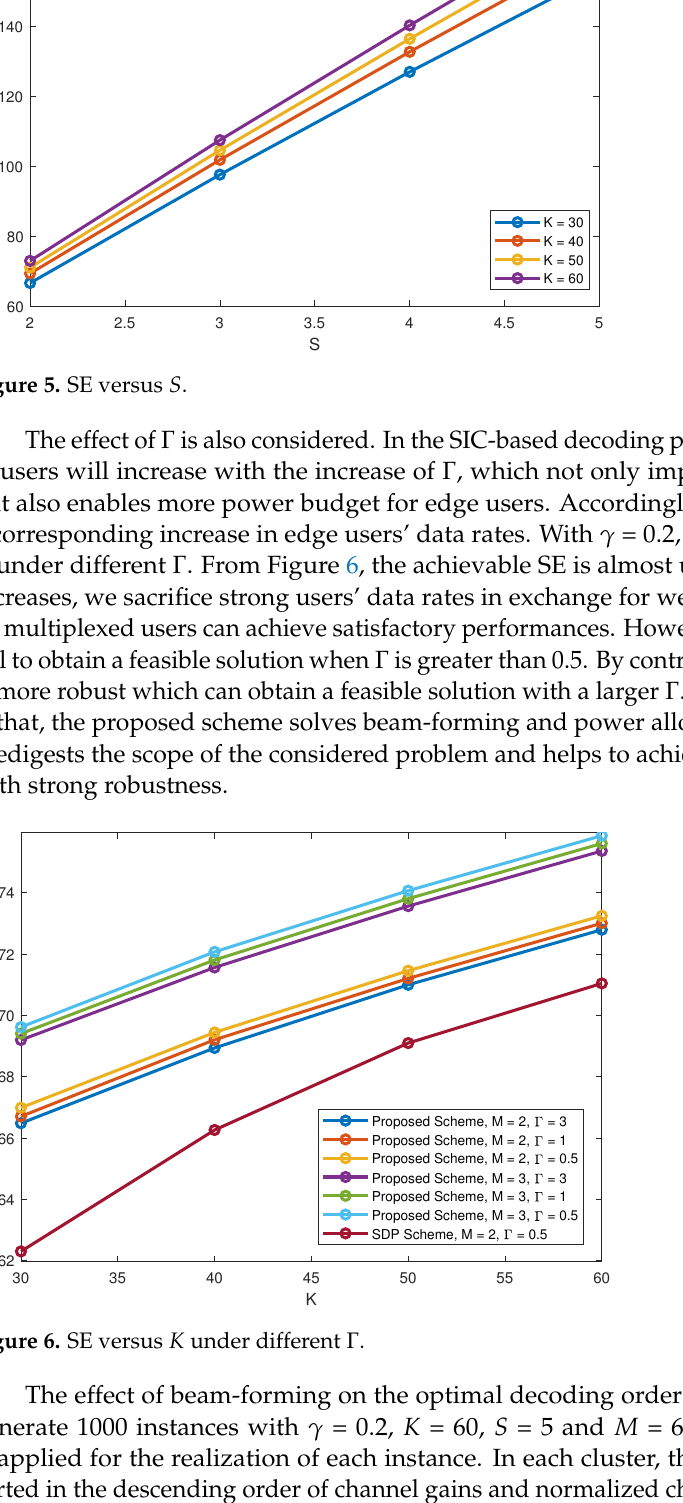
Figure 6. SE versus K under different Γ